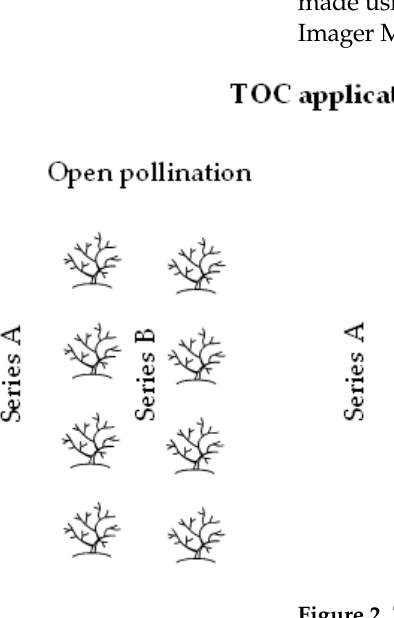
Figure 2. The scheme of the experiment. TOC application—application of the titanium organic complex; no TOC application—no application of the titanium organic complex; Series A—plants, for which flowers were selected for microscopic observation of pollination and fertilization; Series B—plants, for which flowers were selected for measurements of fruit set and development. TOC—titanium organic